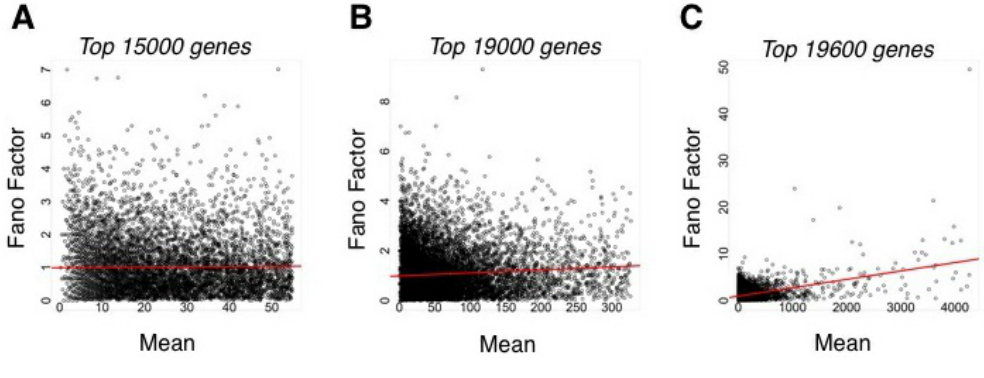
Figure 3. Noise properties of RNA-seq technical replicate data. In every panel, the mean vs. the Fano factor for individual genes is plotted. Data were taken from [19]. Black circles correspond to individual genes, and the red line corresponds to a linear regression of the mean vs. the Fano factor for the indicated number of genes. Behavior of the ( A ) first 15,000 genes; ( B ) first 19,000 genes; or ( C ) first 19,600 genes as ranked by increasing